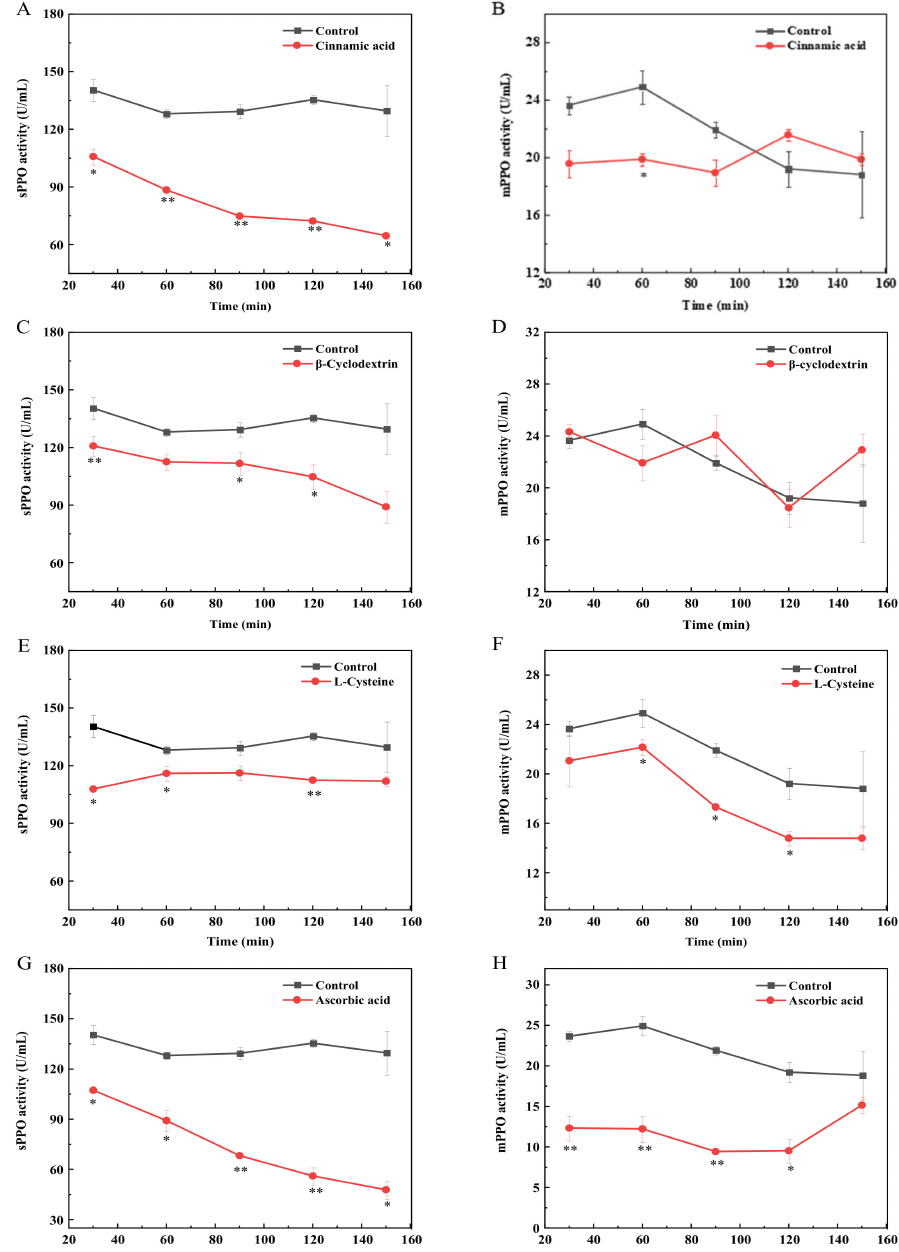
Figure 3. Effects of pre-incubation of sPPO and mPPO with inhibitors on subsequent PPO activity. Cinnamic acid with sPPO ( A ) and mPPO ( B ); β CyD with sPPO ( C ) and mPPO ( D ); L-Cys with sPPO ( E ) and mPPO ( F ); AA with sPPO ( G ) and mPPO ( H ). Final concentration of the four inhibitors was 3 mM. * indicates a significant difference between the groups with and without inhibitors at the same incubation time ( p < 0.05); ** indicates a highly significant difference ( p <